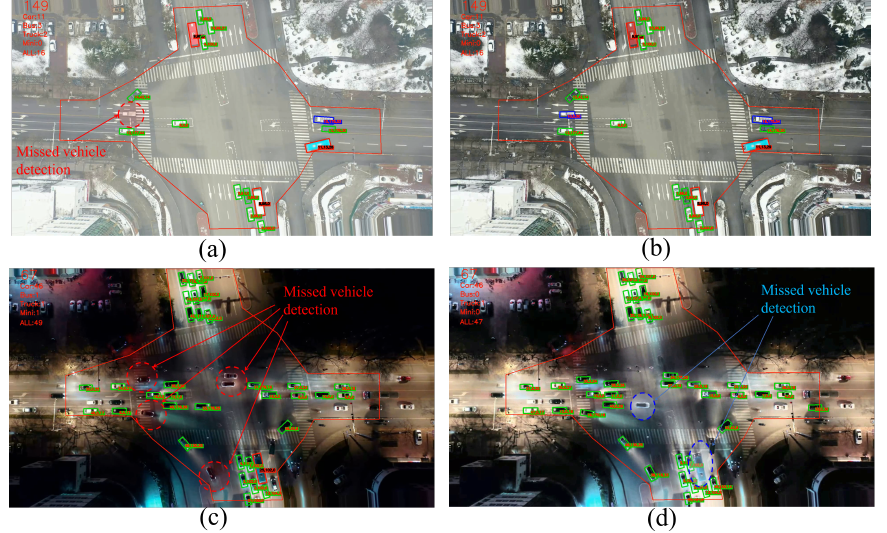
Figure 10. Detection results of the YOLOv5-OBB algorithm with basic weight and enhanced weight on MWVD dataset. ( a , c ) show the detection results of the YOLOv5-OBB with basic weight in UAV images captured on a snowy day and at night, respectively. ( b , d ) show the detection results of the YOLOv5-OBB with enhanced weight in the enhanced same